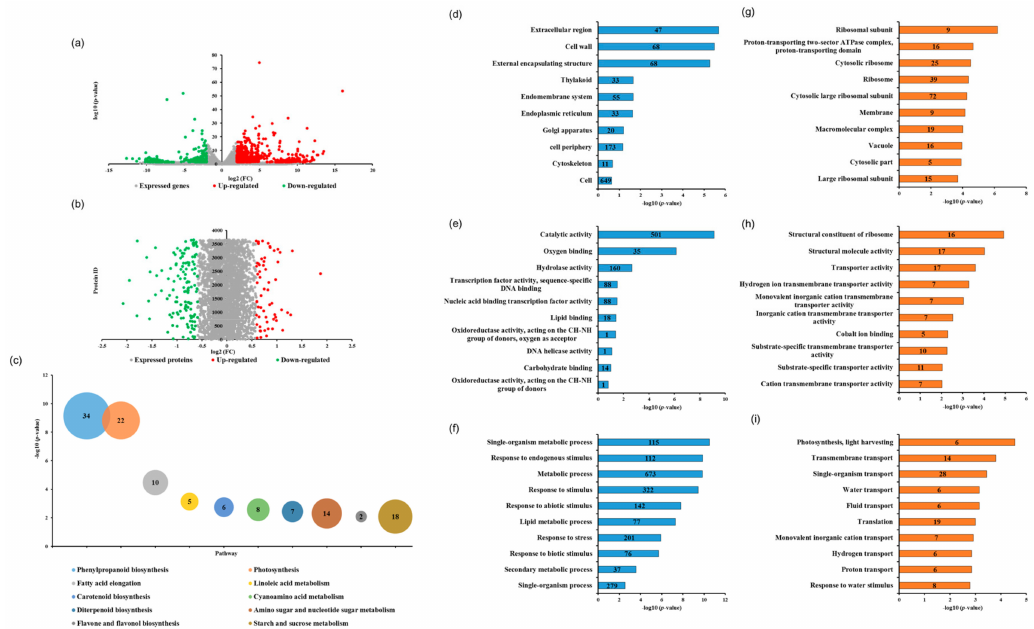
Figure 2. Transcriptome and proteomic analysis of the dmt1 mutant and WT. ( a ) Volcano plot of genes that were di ff erentially expressed between the dmt1 mutant and WT in RNA-seq (1069 upregulated and 235 downregulated). The red dots in the right of the plot represent significantly upregulated genes, and the green dots in the left of the plot represent significantly downregulated genes. ( b ) Di ff erentially abundant proteins (DAPs) in iTRAQ. Red spots indicate 43 upregulated proteins, and green spots indicate 104 downregulated proteins in the dmt1 mutant compared to the WT. ( c ) Top 10 pathway enrichments of DEGs, the ordinate indicates -log 10 ( p -value), bubble size and date labels indicate gene numbers. ( d – f ) Top 10 GO ontology enrichment of DEGs based on cellular component ( d ), molecular function ( e ), and biological process ( f ). The abscissa indicates -log10 ( p -value), and the number in the data labels indicate the gene numbers. ( g–i ) Top-10 GO ontology enrichment of DAPs based on cellular component ( g ), molecular function ( h ), and biological process ( i ). The abscissa indicates -log10 ( p -value), the number in the data labels indicate gene